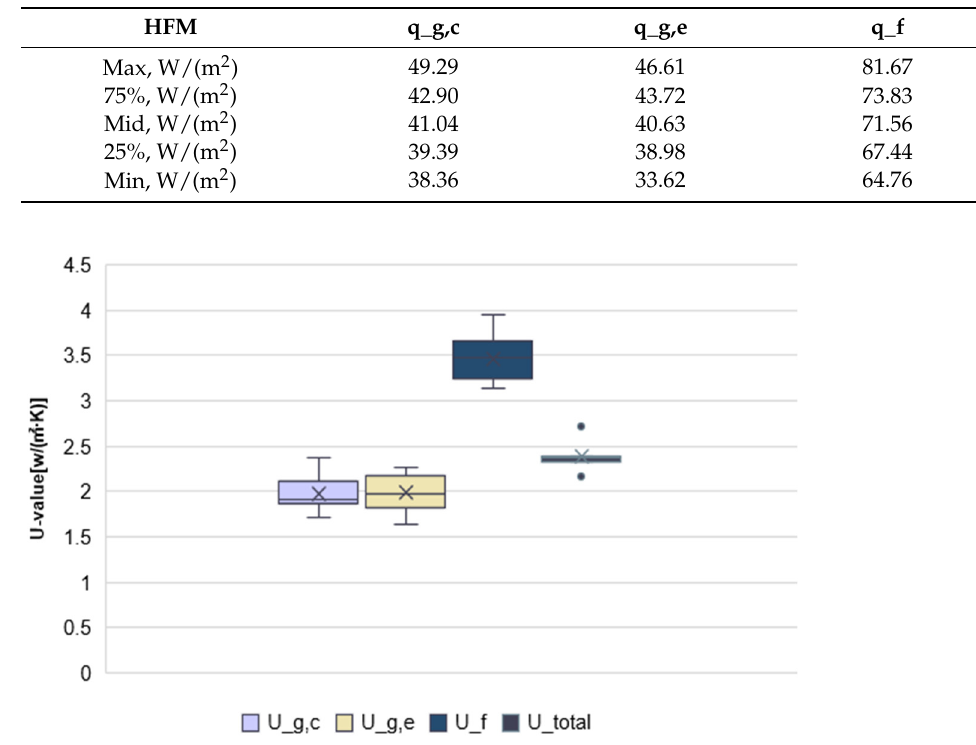
Table 6. Window U-value using the HFM method.